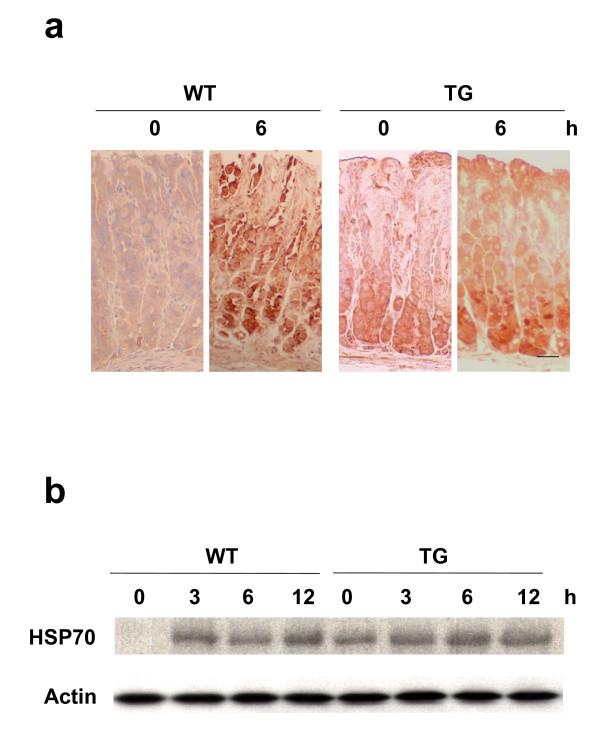
HSP70 expression in the gastric mucosa. (a) Immunostaining of HSP70. HSP70 was induced along the necrotic region and the lower glandular region of the WT mucosa after ethanol injury, whereas it was constitutively expressed in the lower glandular region of the TG mucosa before and after the injury. Ethanol-injured mucosa was stained 6 h after the ethanol administration. Scale: 100 μm. (b) Immunoblotting of HSP70. HSP70 blot was assessed 0, 3, 6, 12 h after the ethanol injury. HSP was induced after ethanol injury in the WT mucosa, while it was constitutively expressed in the TG mucosa before and after the injury.